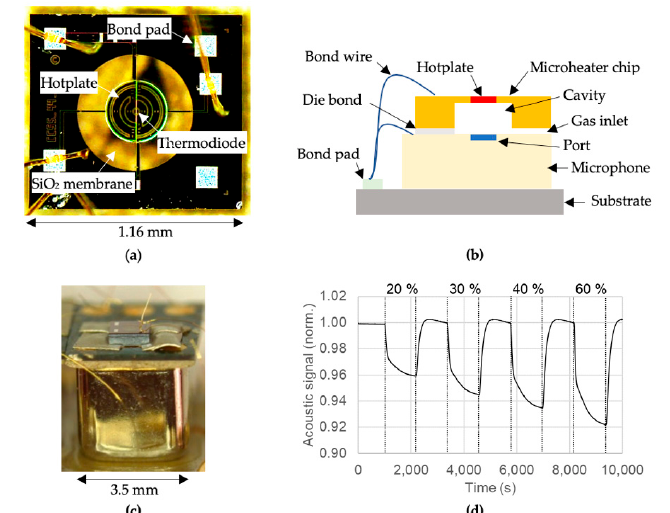
Figure 1. ( a ) Optical image of the microheater chip used for the thermal acoustic gas sensor; ( b ) schematic diagram showing the sensor construction; ( c ) image of the fabricated sensor; ( d ) response to various CO 2 gas